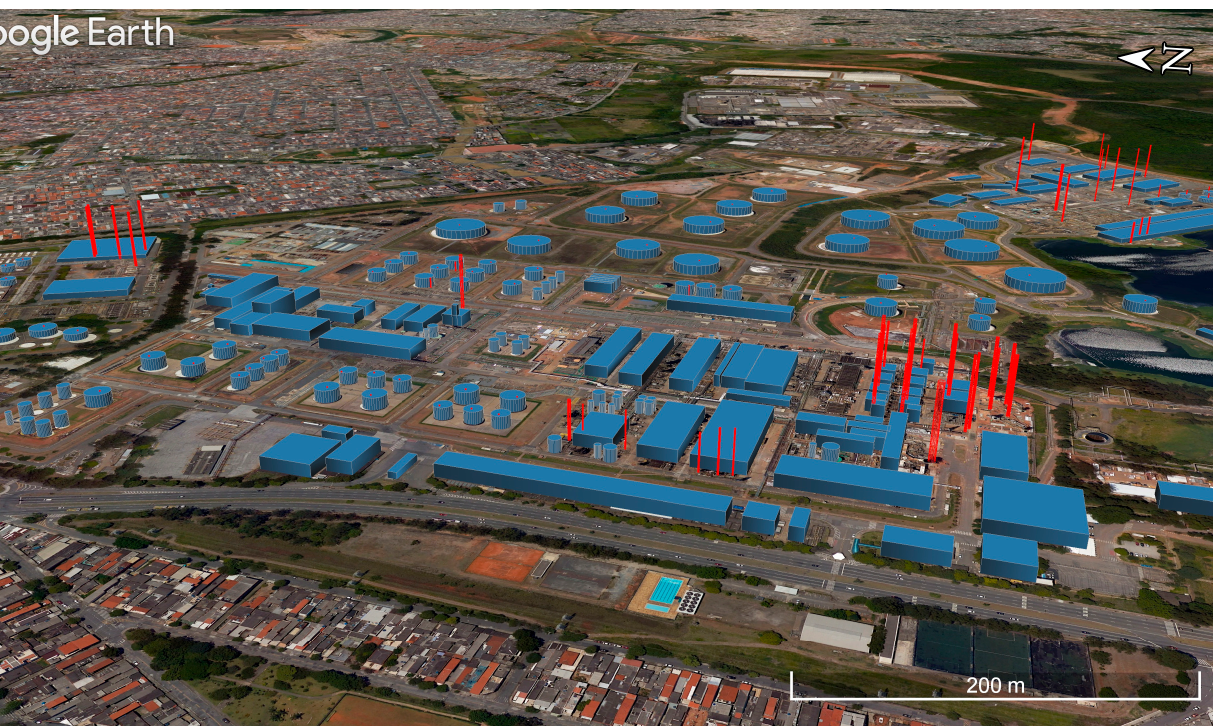
(Table S2)), topographical data for sources and receptors, and meteorological data (Table S3) as inputs and outputs of ambient pollutant concentrations at receptors. Two preprocessors called AERMAP and AERMET convert raw topographical and meteorological data to the readable format for AERMOD through two separate runs before dispersion modeling runs [40,41].